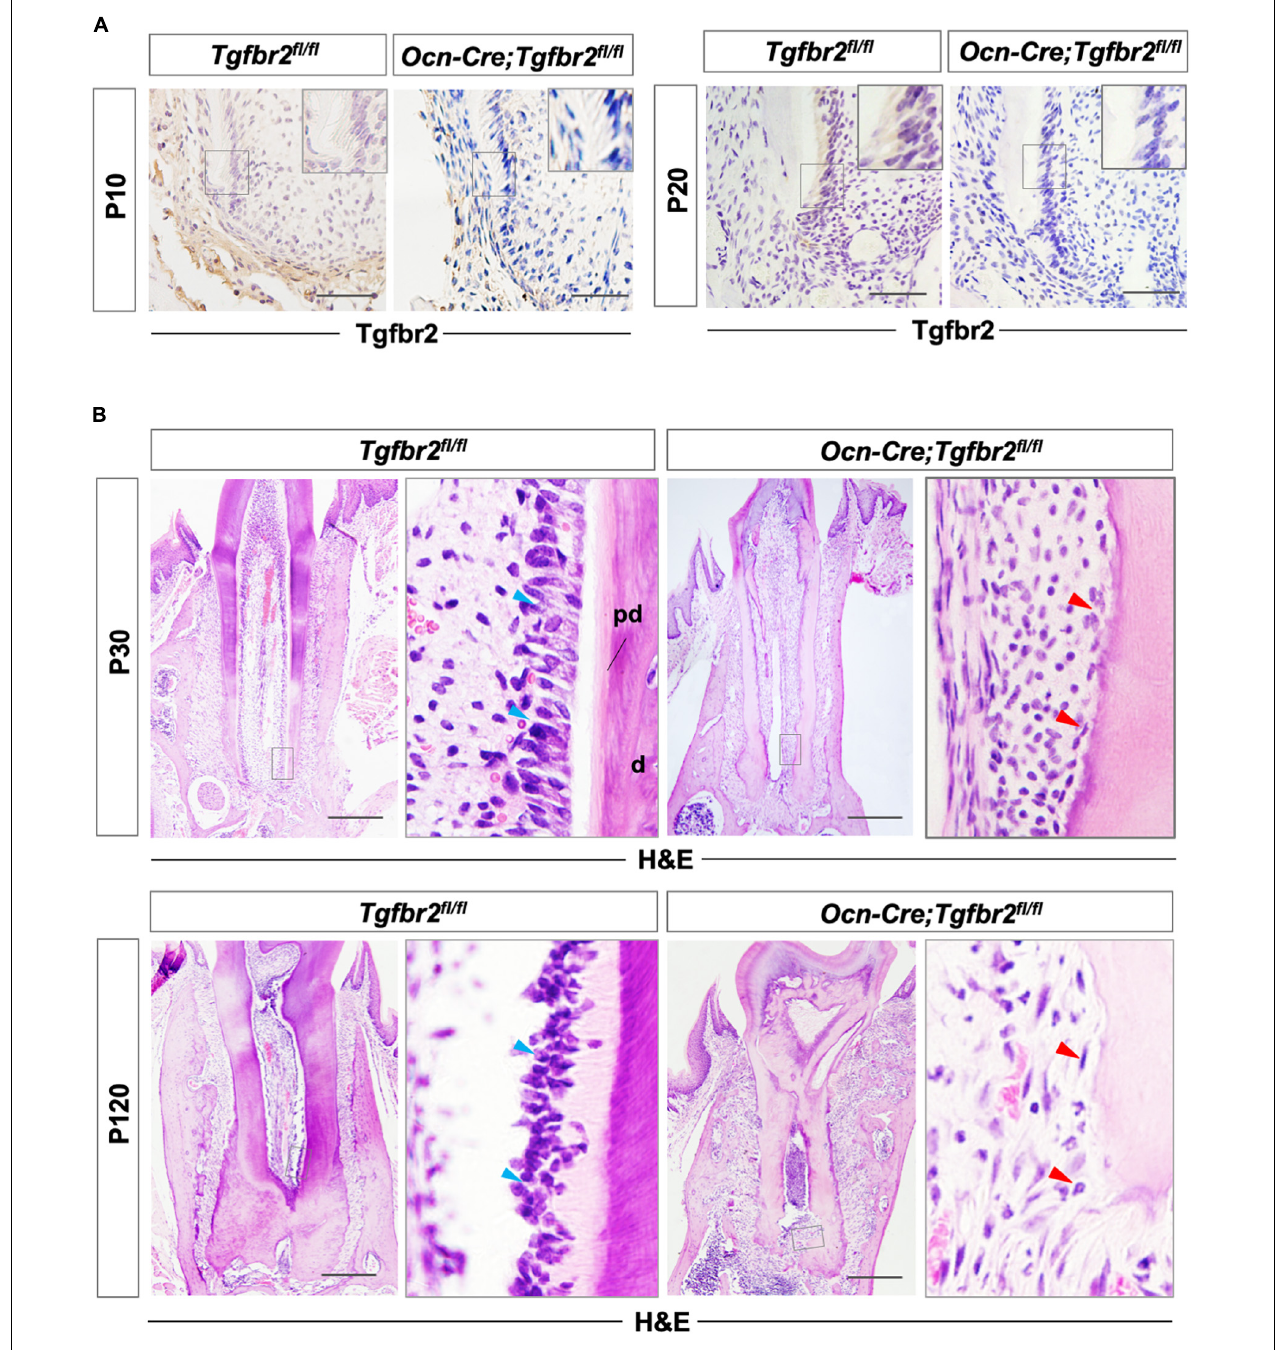
FIGURE 1 | Disrupted tooth root development and formation of osteodentin in Ocn-Cre; Tgfbr2 fl / fl mice. (A) Tgfbr2 is ablated in root odontoblasts in Ocn-Cre ; Tgfbr2 fl / fl mice at P10 and P20 ( n = 4 mice/per genotype). The top right panels show high-magnification image of the area boxed in gray on the left. (B) Abnormal root odontoblasts and root dentin formation in Ocn-Cre ; Tgfbr2 fl / fl mice at P30 and P120. The right panels show the high-magnification image of the area boxed in gray on the left. Blue arrowheads indicate columnar-shaped odontoblasts in Tgfbr2 fl / fl mice, red arrowheads indicate irregular-shaped odontoblasts and formation of osteodentin in Ocn-Cre ; Tgfbr2 fl / fl mice. pd, pre-dentin; d, dentin. Scale bars: 20 µ m (A) , 100 µ m (B) .